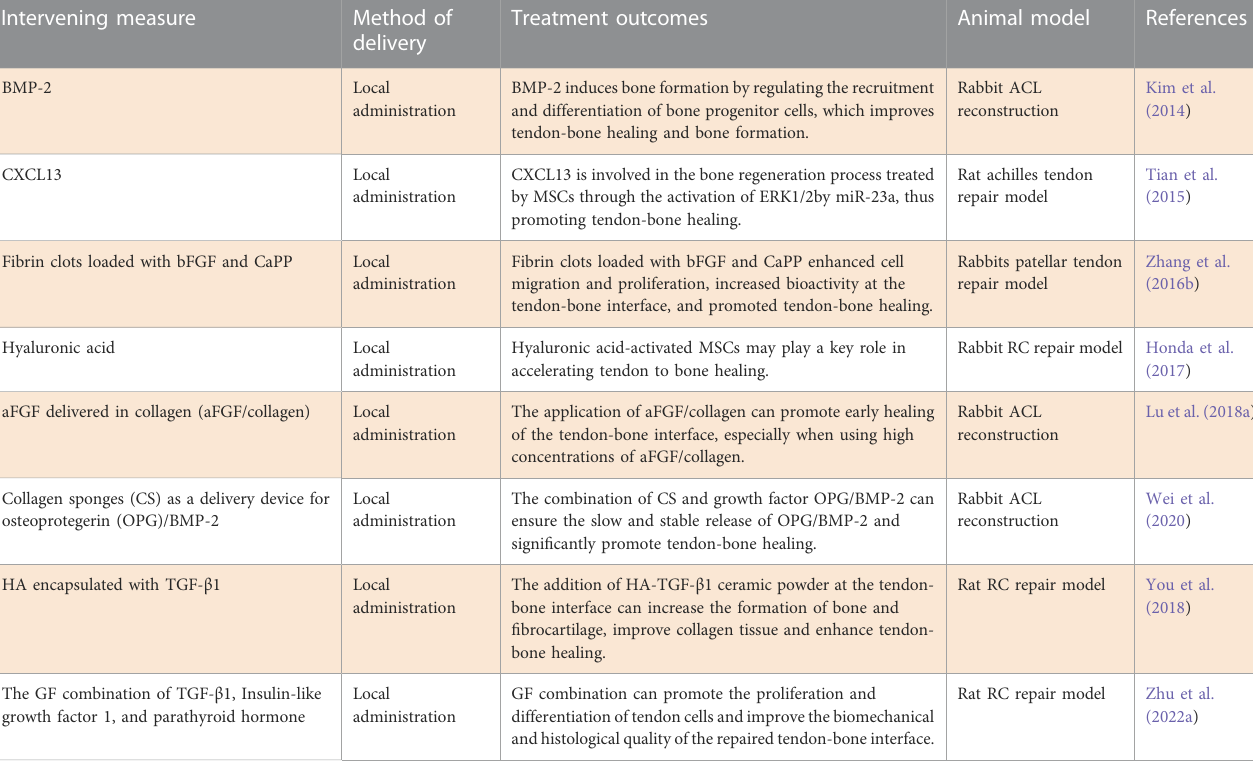
TABLE 3 Preclinical studies on the application of cell factors to promote tendon-bone healing.